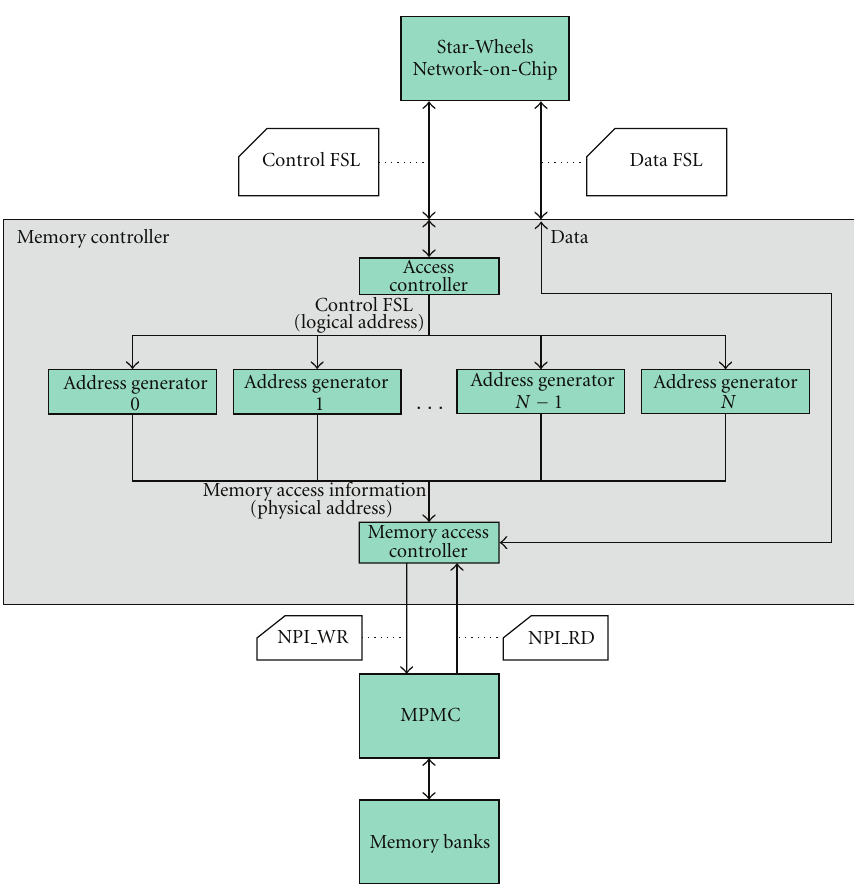
Figure 2: Overview of the adaptive memory